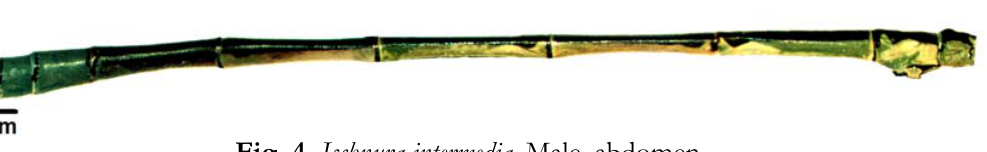
Fig. 4. Ischnura intermedia, Male, abdomen.